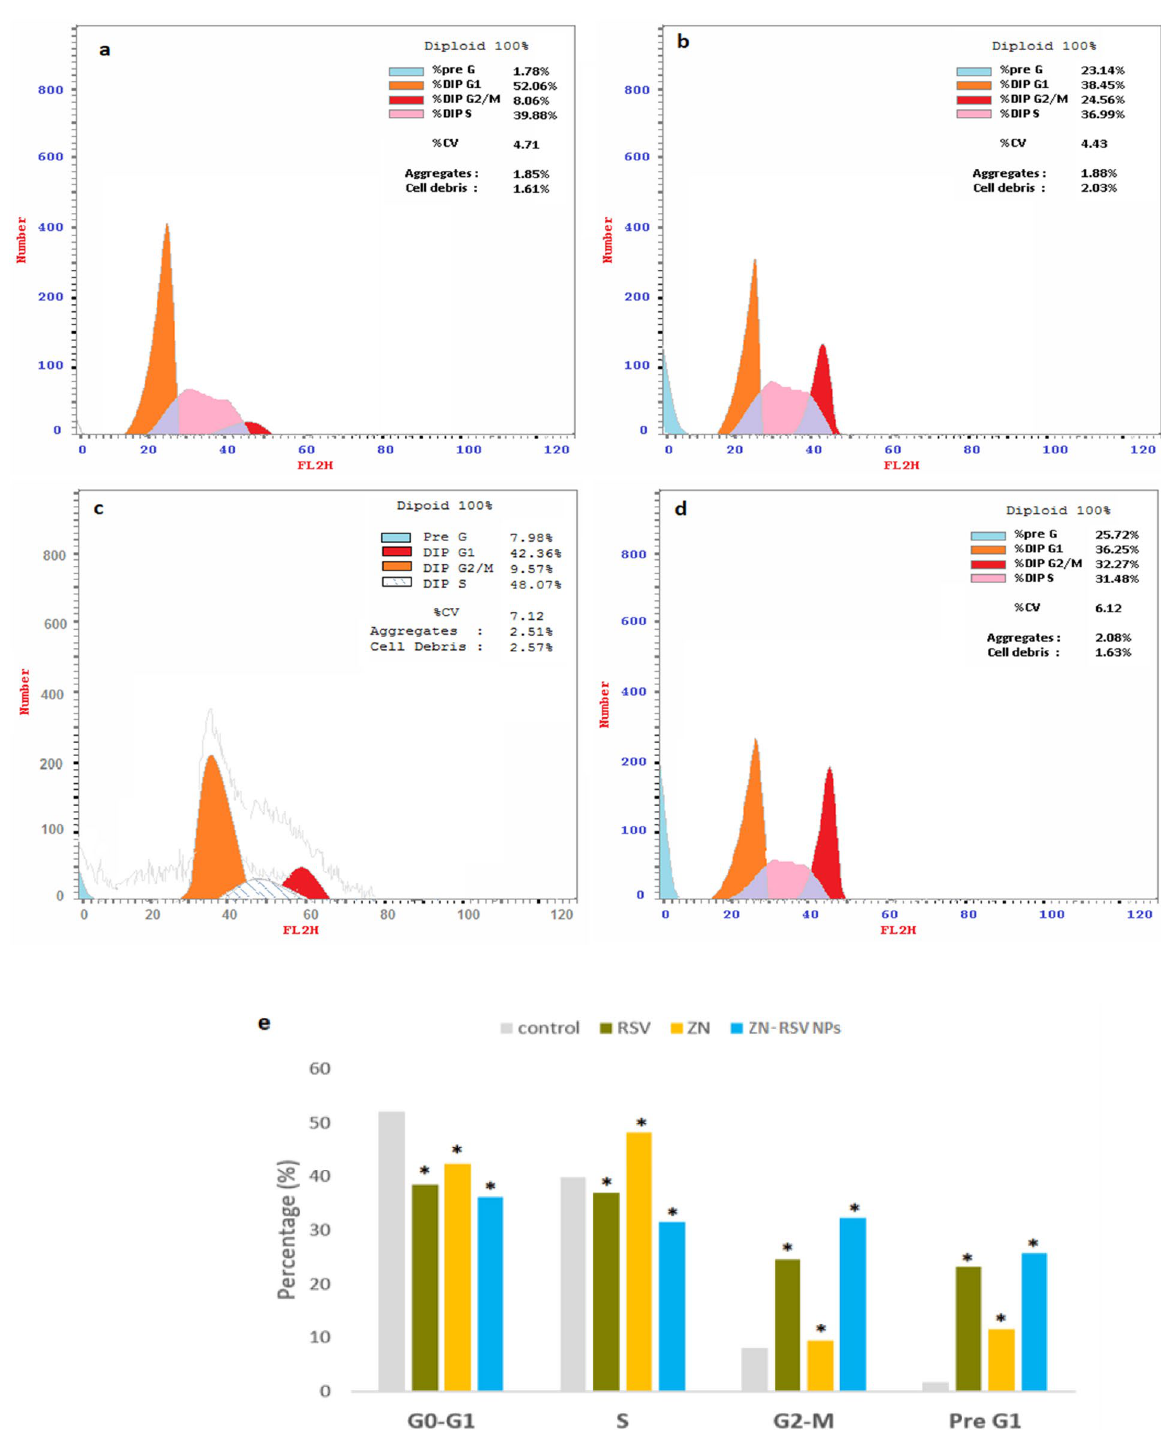
Figure 6. Impact of ZN-RSV NPs on cell cycle phases. ( a ) Control, ( b ) RSV, ( c ) ZN, ( d ) ZN-RSV NPs, ( e ) graphical presentation of each phase. *Significantly different in comparison with control group at p <